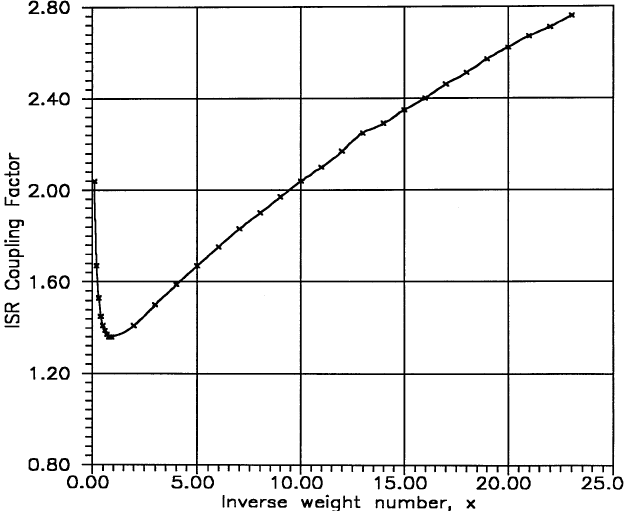
Fig. 9. Variation of the inverse square root of the coupling factor as a function of inverse weight number, x.